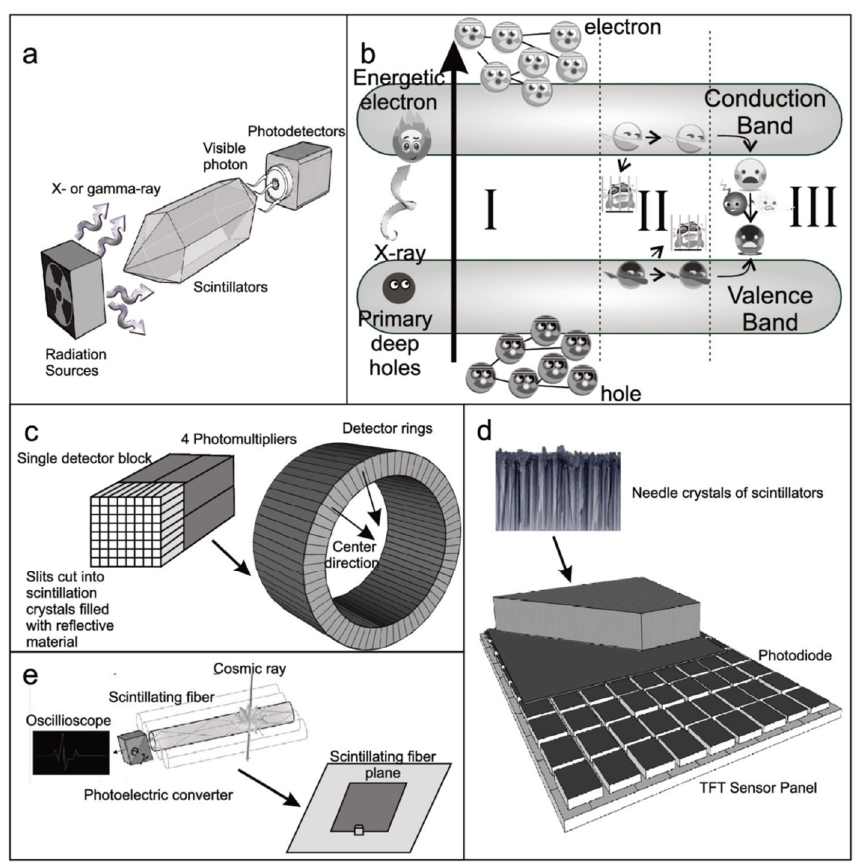
Figure 1. Construction, process and applications of scintillators: ( a ) a scintillation detector with the main constituent parts; ( b ) a sketch of the scintillator process in crystal. The process is divided into three consecutive stages of (I) conversion, (II) transport and (III) luminescence, which are described in the text; ( c ) schematic of a detector block and ring of scintillators in a positron emission tomography scanner; ( d ) needle crystal scintillators used in X-ray digital flat panel detectors; ( e ) scintillating fibers for cosmic ray detection and high-energy physics experiments. Copyright permission from